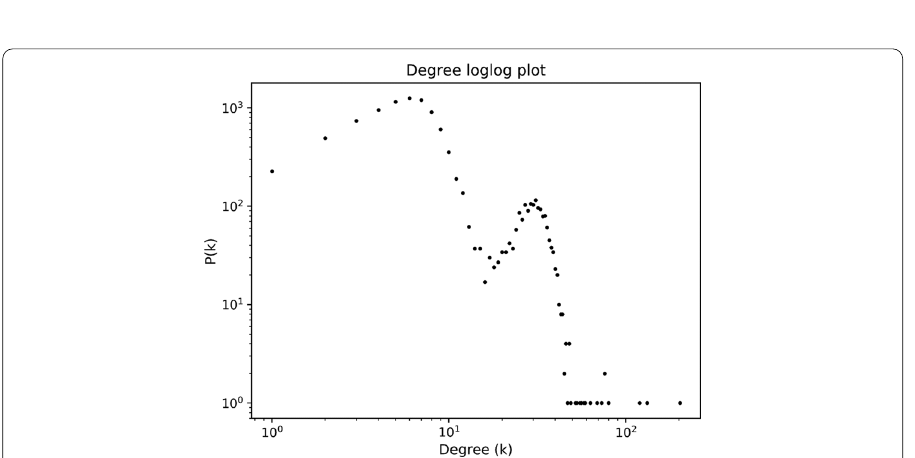
Fig. 2 The degree distribution of a network generated with 10,000 nodes shows two peaks representing the combination of workplace interactions. The first peak at k ~ 6 is due to the scale-free network of non-essential workplace interactions and the second peak at k ~ 25 is coming from the random network of essential workplace interaction. The high-degree tail represents the hubs, i.e., the individuals who have